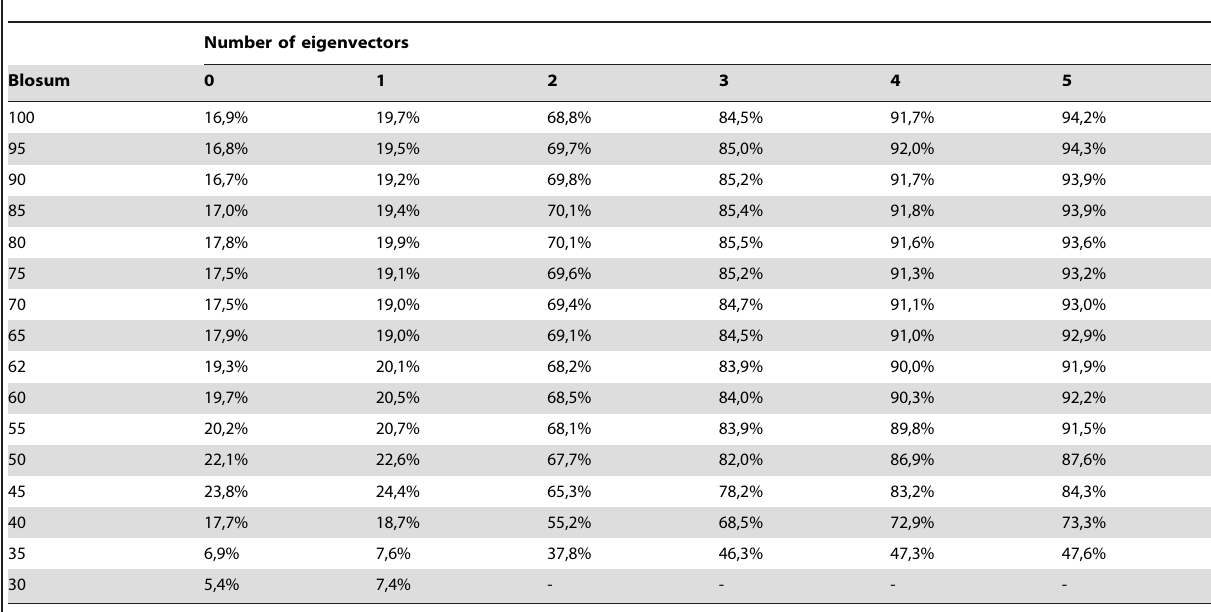
Table 2. The variance explained by the eigenvectors in reconstructed BLOSUM